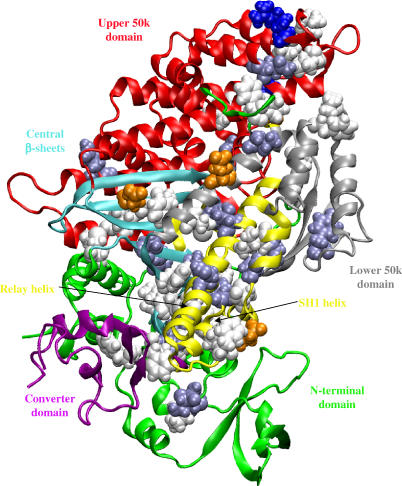
Mapping of the 52 Strongly Coupled Core Residues (in van der Waals Form) to the Structure of Dictyostelium Myosin Motor Domain (PDB Code 1VOM)The structure of the motor domain is displayed using the cartoon scheme with the same color scheme as Figure 9. The coupled residues are colored based on residue type: blue, basic; orange, acidic; slate blue, polar; white, nonpolar.